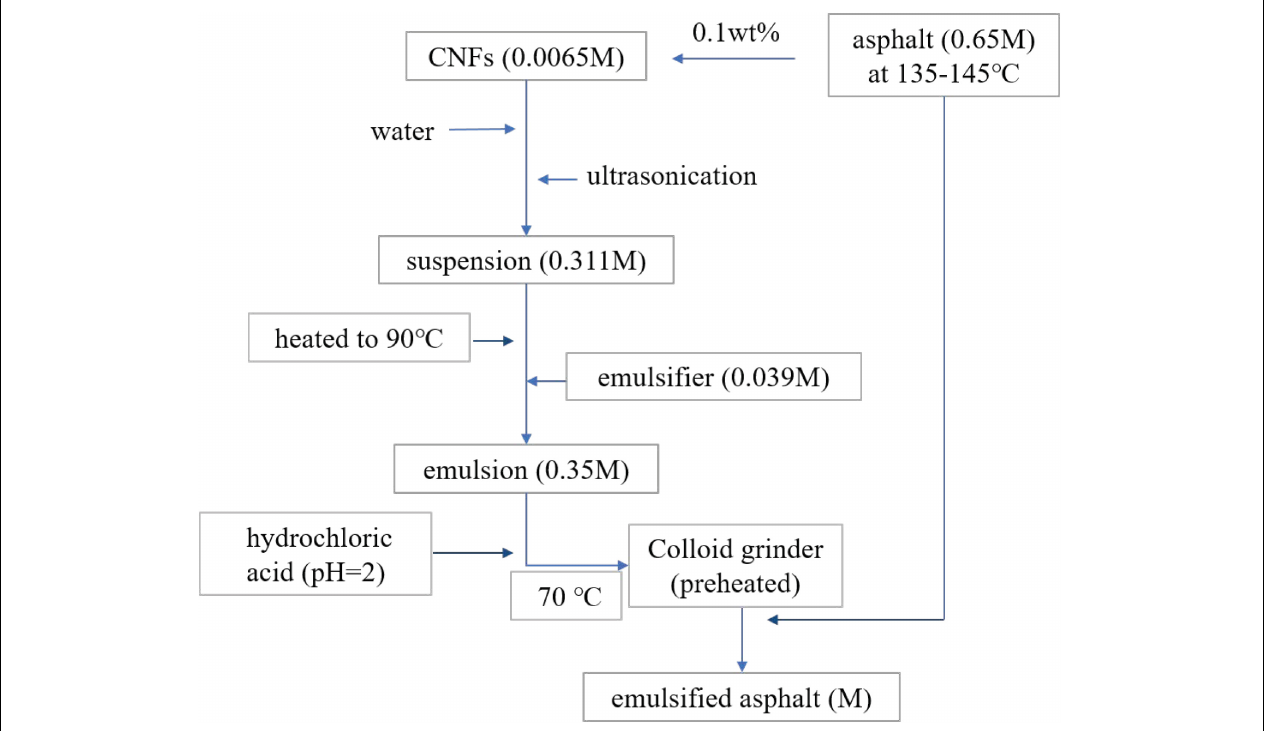
FIGURE 5 | Proportion of material and preparation for CNFs-emulsified asphalt.